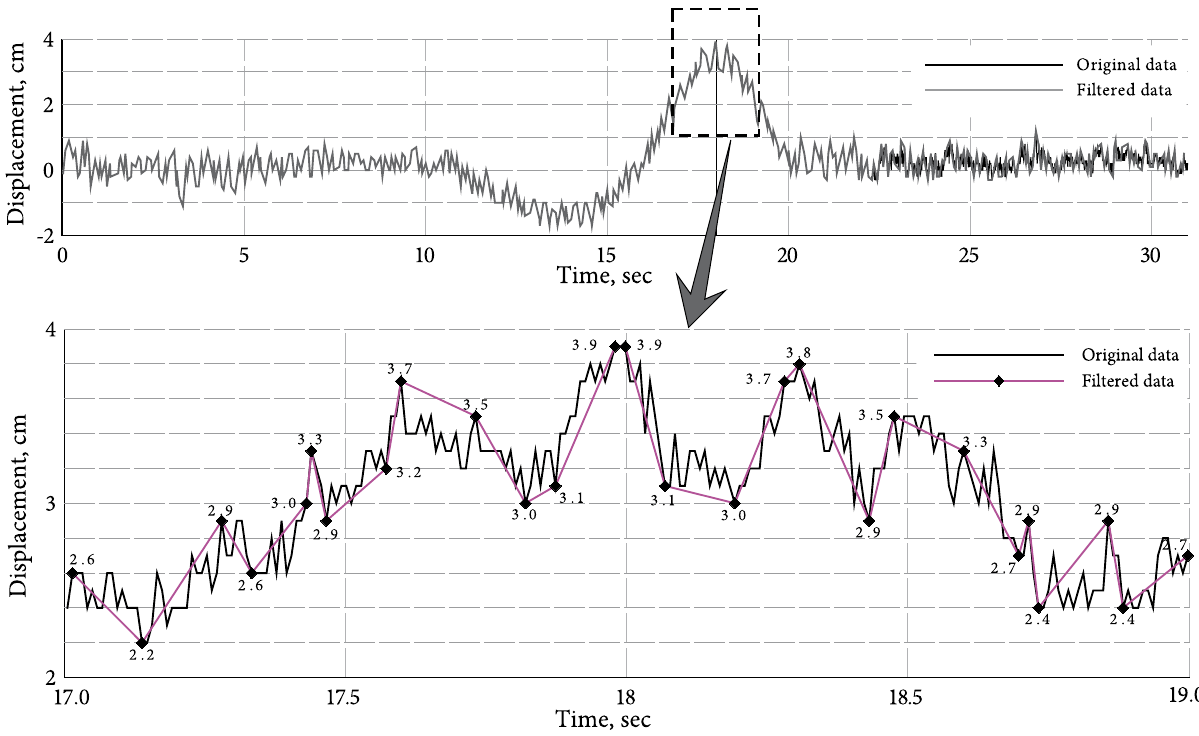
Fig. 6. Filtering method of vibration